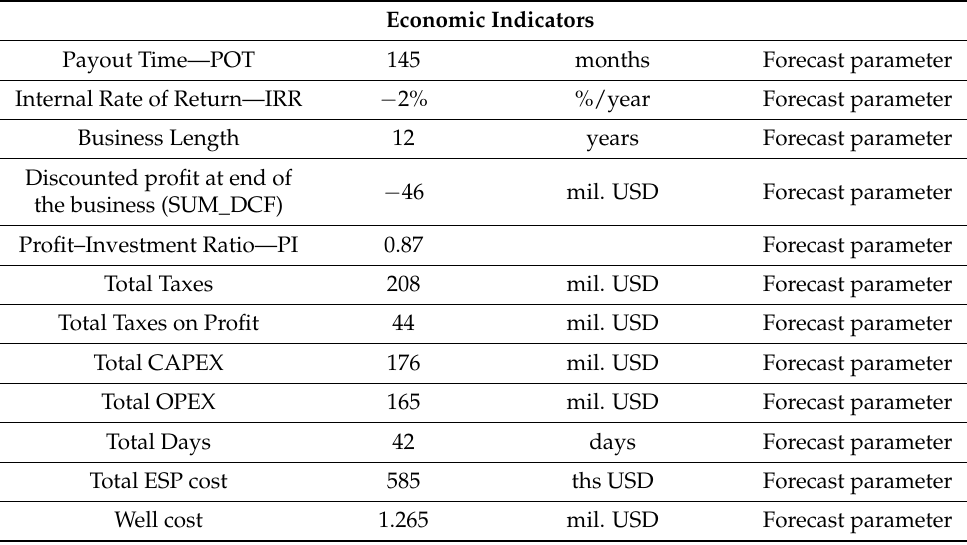
Table 2. Table with Forecast